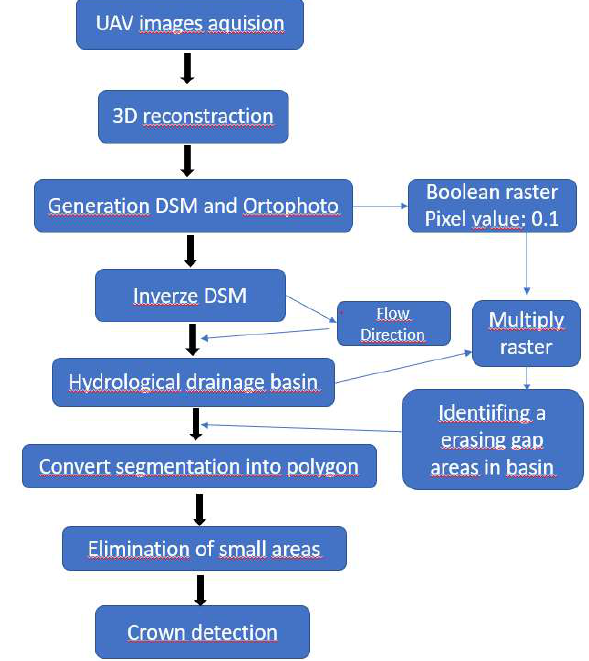
Figure 4. Scheme of crown detection